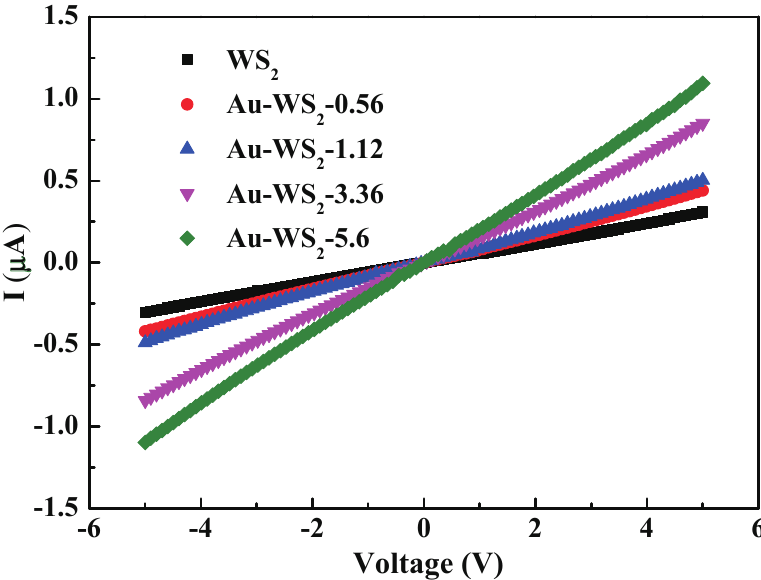
Figure 5. The polarization curves of the sensors using WS 2 and Au/WS 2